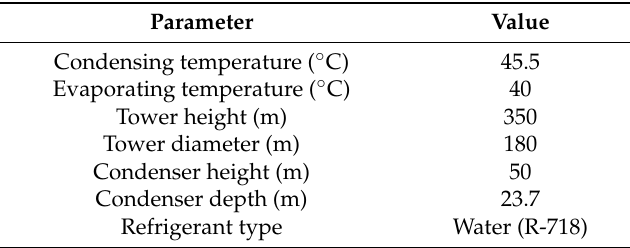
Table 4. Baseline operating conditions of the secondary loop and key parameters for the parametric